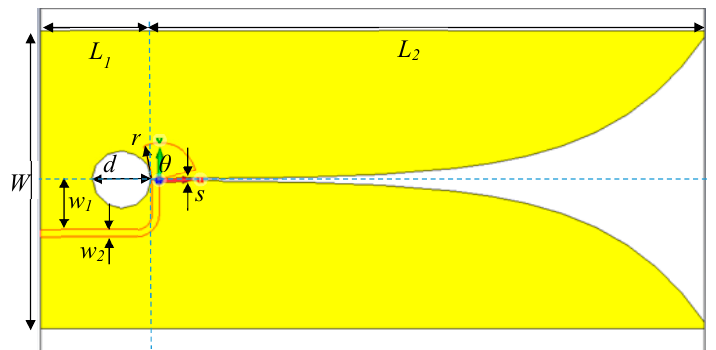
Figure 1. Geometry of the proposed transmitting (Tx) and receiving (Rx) Vivaldi antennas.